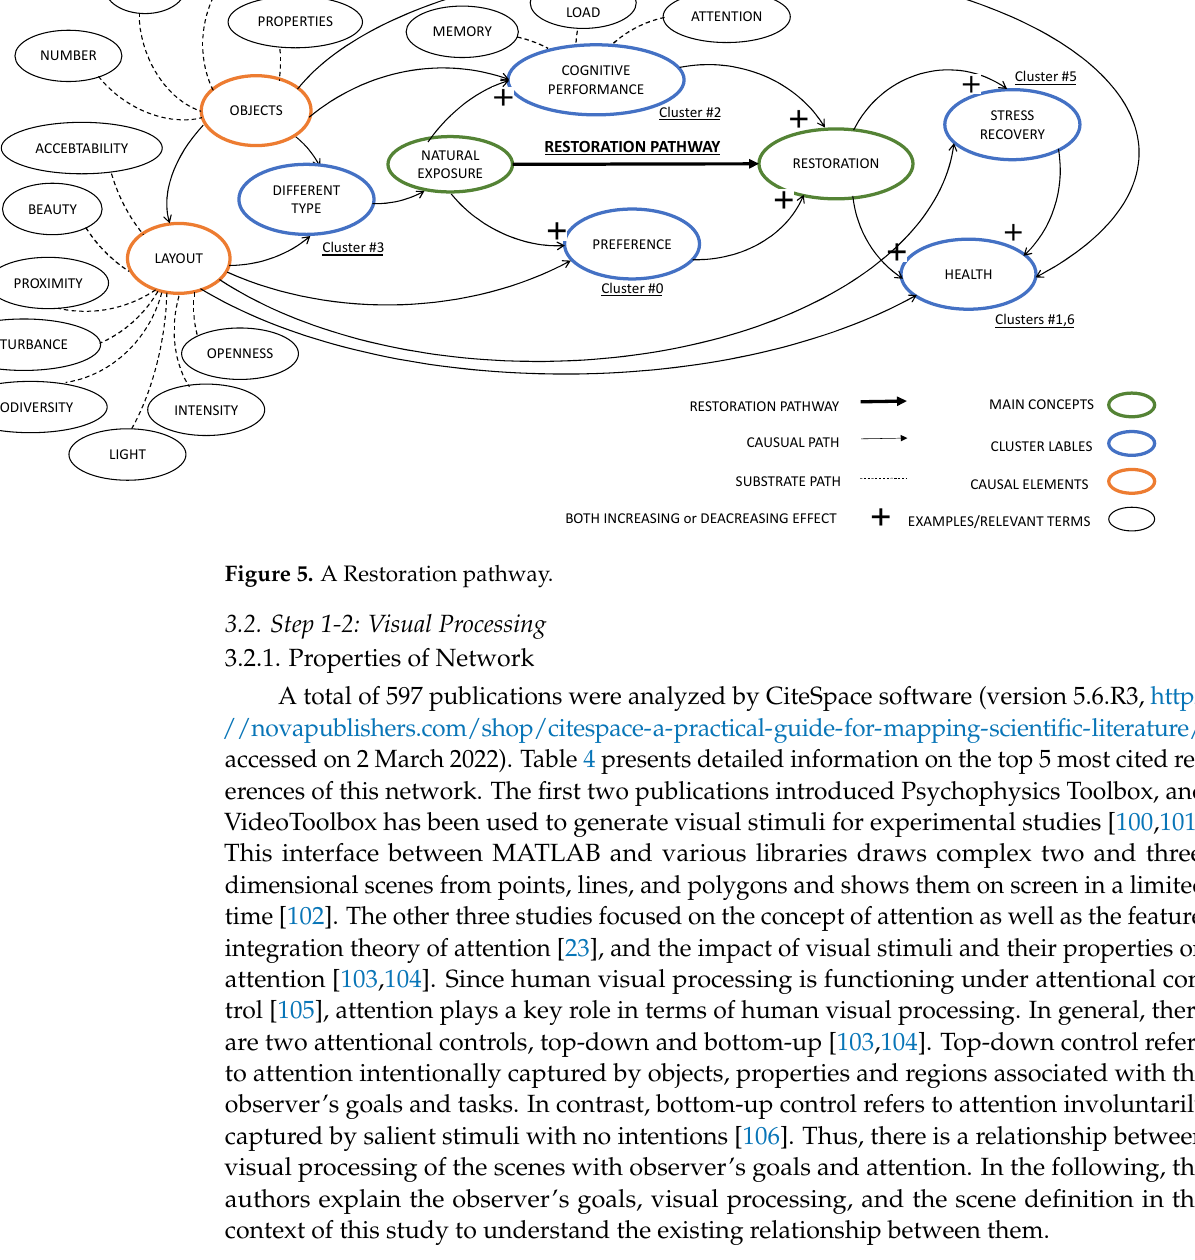
Table 4. Top 5 most cited references of network for the first step of the review, visual processing.